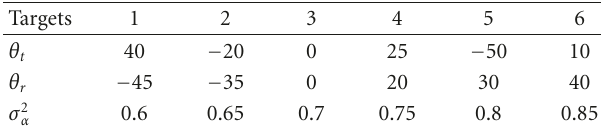
Table 1: Locations of the nine targets.